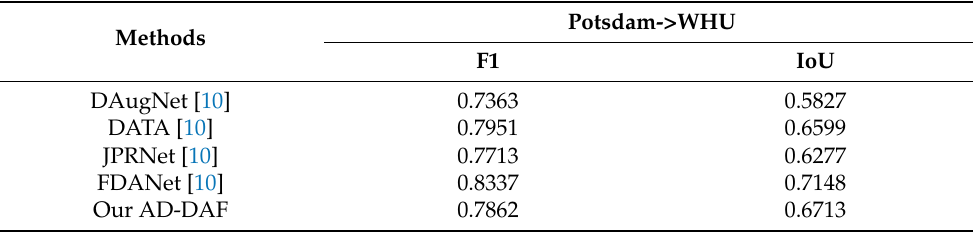
Table 4. The comparison results from the source domain of the Postdam datasets to the target domain of the WHU aerial building